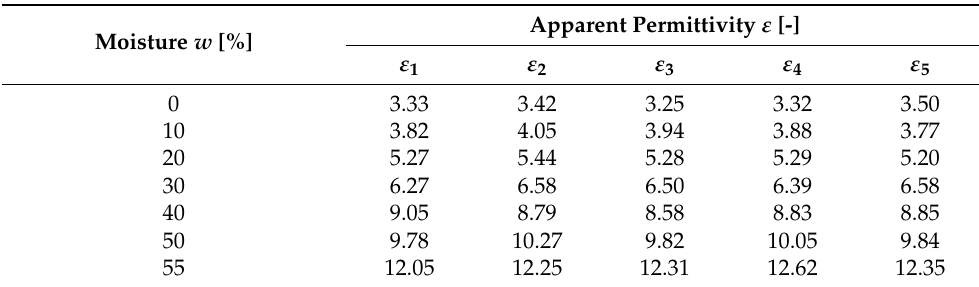
Table 5. Results of the apparent permittivity ε measurements with the S1 surface sensor for different values of moisture w ; 600 c.c. sample.